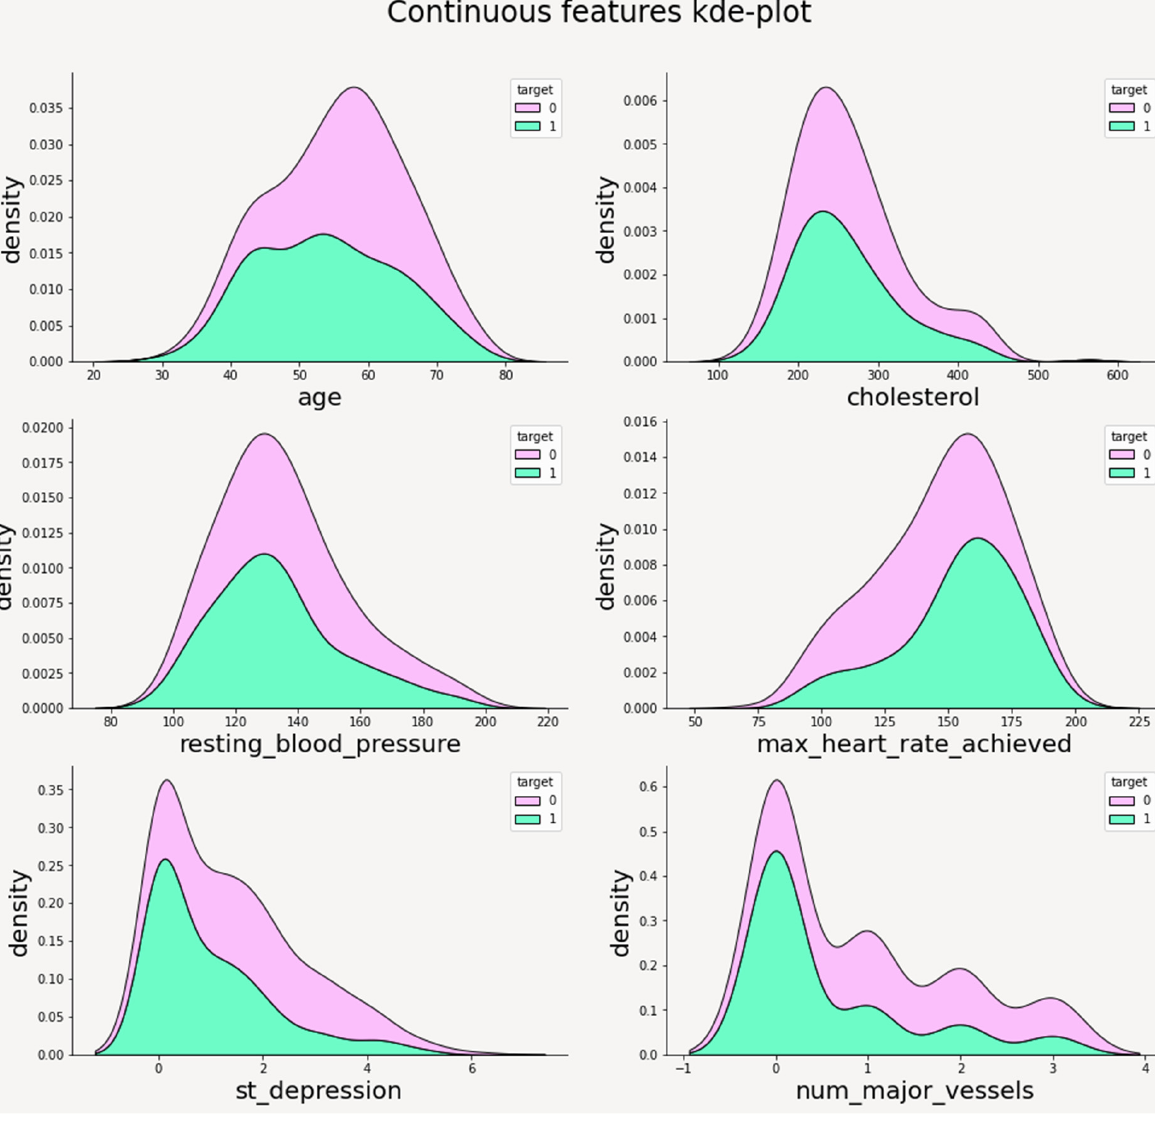
Figure 6. Continuous feature Kernel Density Estimate Plot.